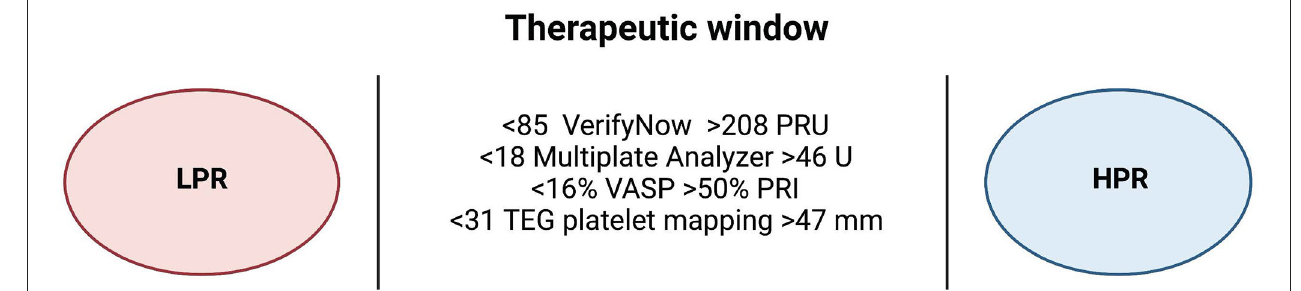
FIGURE 3 | Therapeutic window of different platelet function testing assays. An expert consensus statement has defined the therapeutic window of platelet reactivity using different platelet function testing assays. Measurements higher than the therapeutic window are defined as high platelet reactivity (HPR), and patients with HPR are associated with high ischemic risk while measurements lower than the therapeutic window are defined as low platelet reactivity (LPR), and patients with LPR are at high bleeding risk. Created with BioRender.com. HPR, high platelet reactivity; LPR, low platelet reactivity; PRU, platelet reactivity unit; PRI, platelet reactivity index; TEG, thromboelastography; U, unit; VASP, vasodilator-stimulated